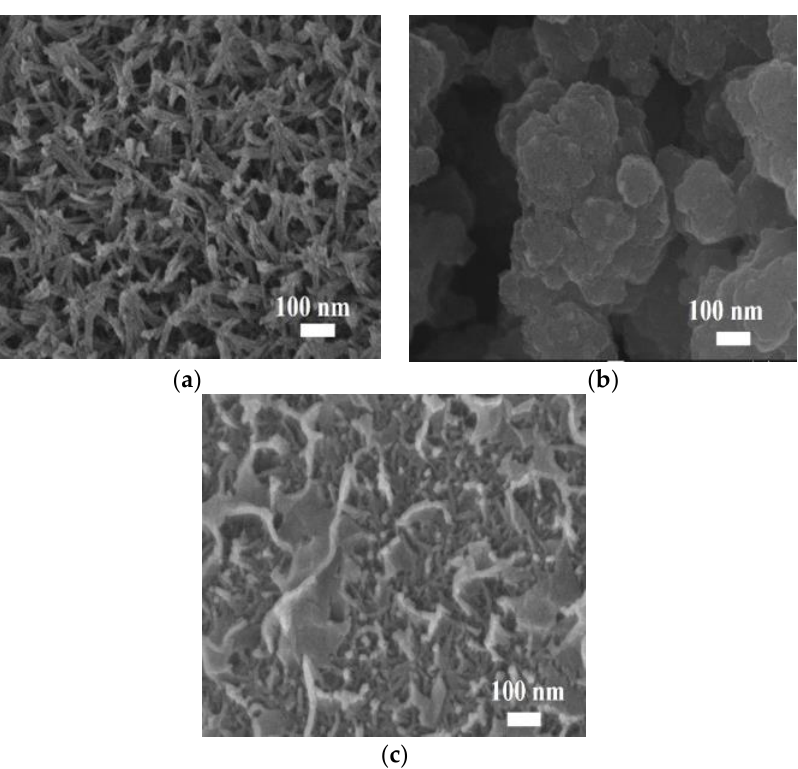
Figure 2. SEM image of ( a ) MnO 2 -CC, ( b ) PPy-CC, and ( c ) PPy-MnO 2 -CC electrodes, respectively.